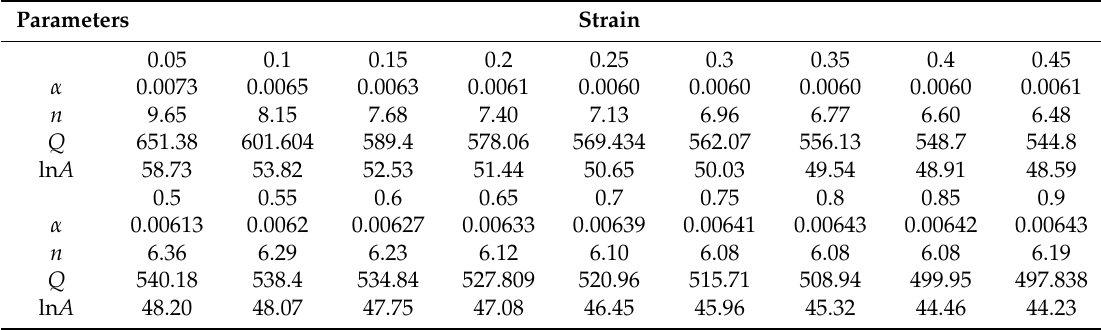
Table 3. Activation energy of deformation Q (kJ/mol), stress exponent n , materials constants A and a during hot deformation of the H13-mod steel.